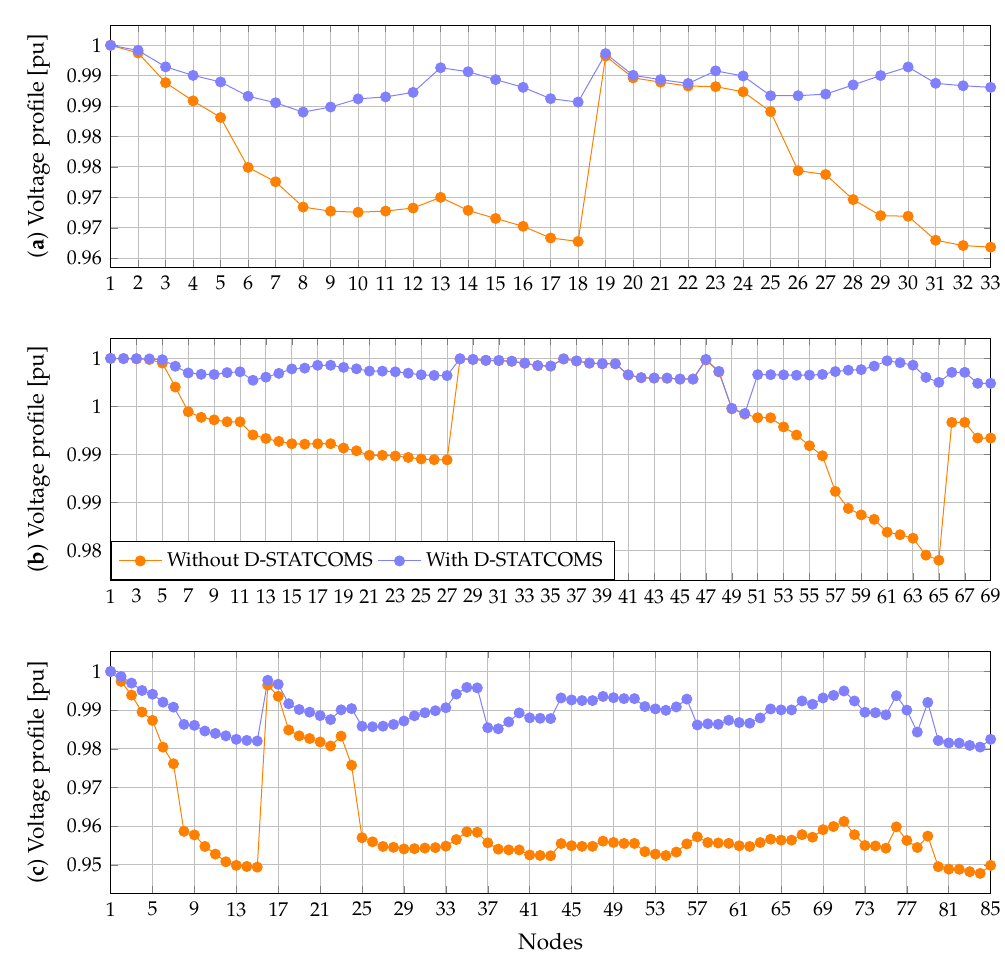
Figure 3. Comparison of the voltage profiles with and without D-STATCOM installation: ( a ) mod- ified IEEE 33-bus test system; ( b ) modified IEEE 69-bus test system; and ( c ) modified IEEE 85-bus test